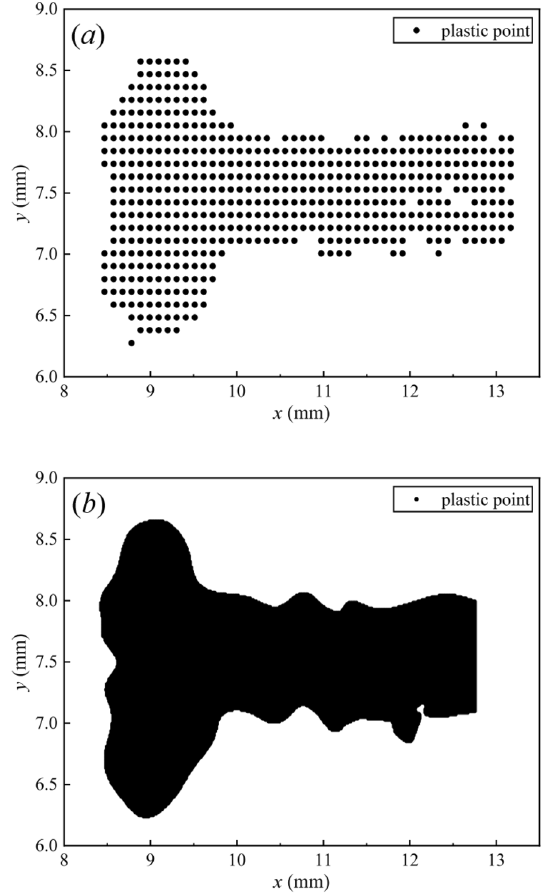
Figure 6 Plastic zone at the crack tip: a Crack tip plastic zone with a pixel spacing of 9; b crack tip plastic zone with a pixel spacing of 1